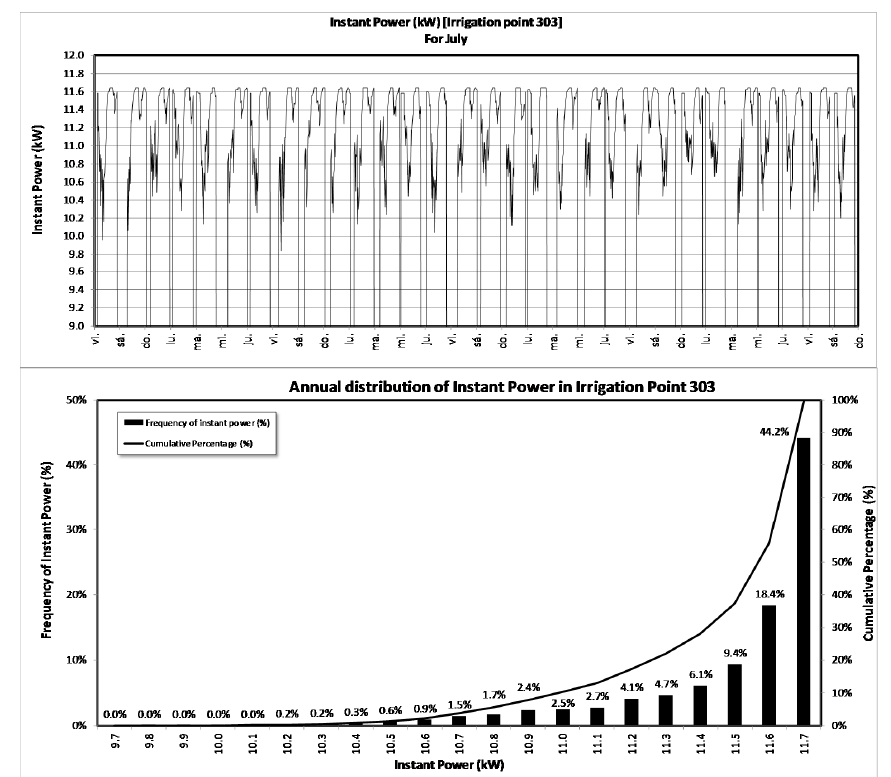
Figure 17. Potential Power in the irrigation point 303. Water 2016 , 8 , 234